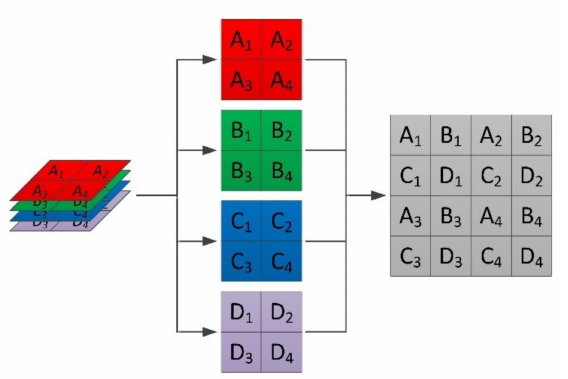
Figure 3. Schematic of